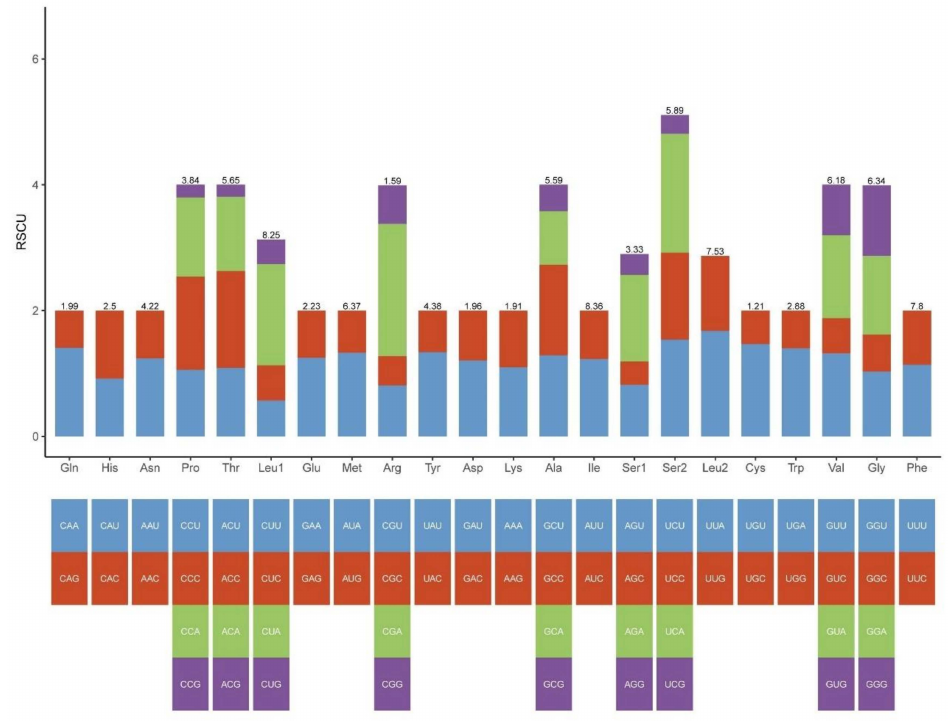
Figure 3. RSCU of the S. jimoS. jimo mitogenome. The bar length represents the accumulated scores of all codons for each amino acid (AA). The numbers on each bar represent the AA ratios of all amino acids in the mitochondrial